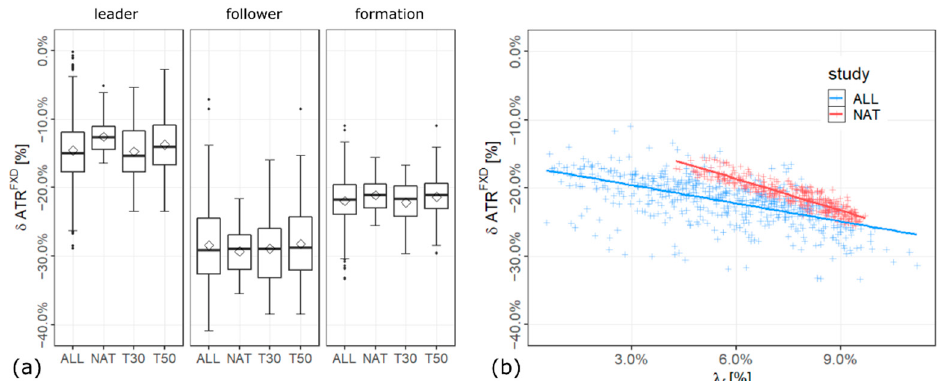
Figure 10. Relative temperature responses δ ATR for the FXD setting separated by leader, follower and formation for the studies performed within this work ( a ); δ ATR against λ f for the ALL and NAT scenarios with regression lines ( b ).